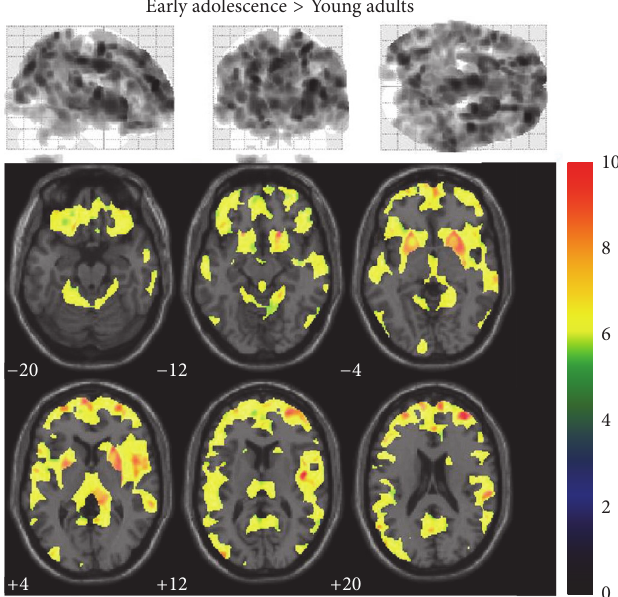
Figure 2: Early adolescence minus young adults statistical parametric mapping. Traditionally presented z -score map (height threshold, 0.05; extent threshold, 50) for the gray matter voxel reductions observed between early adolescence minus young adults (upper). Voxels showing significant changes in gray matter mapped onto a normalized structural image in the axial plane (lower).